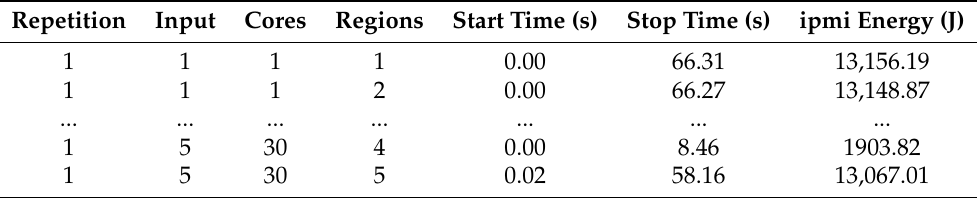
Table 3. Dataframe generated automatically from collected samples using the Python